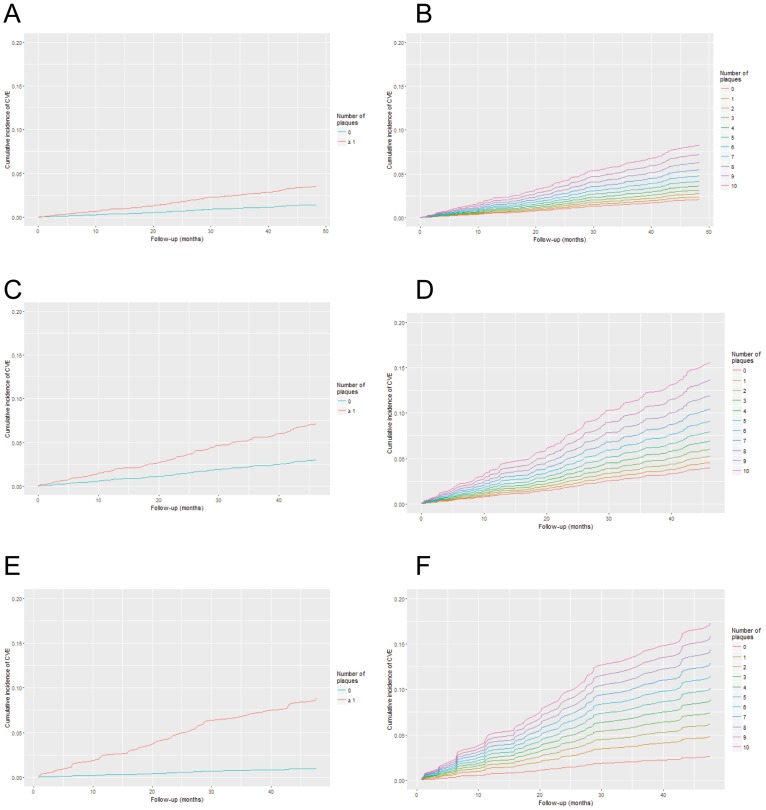
Adjusted cumulative incidence of CVE along the follow up time (months) depending on the presence of atheroma plaque (A, C, and E) or the number of territories with atheroma plaque (B, D and F) in the whole cohort (A, B), CKD patients not on dialysis (C, D) or dialysis patients (E, F).The cumulative incidence was estimated based on the corresponding models provided in Tables 2, 4 and 6.